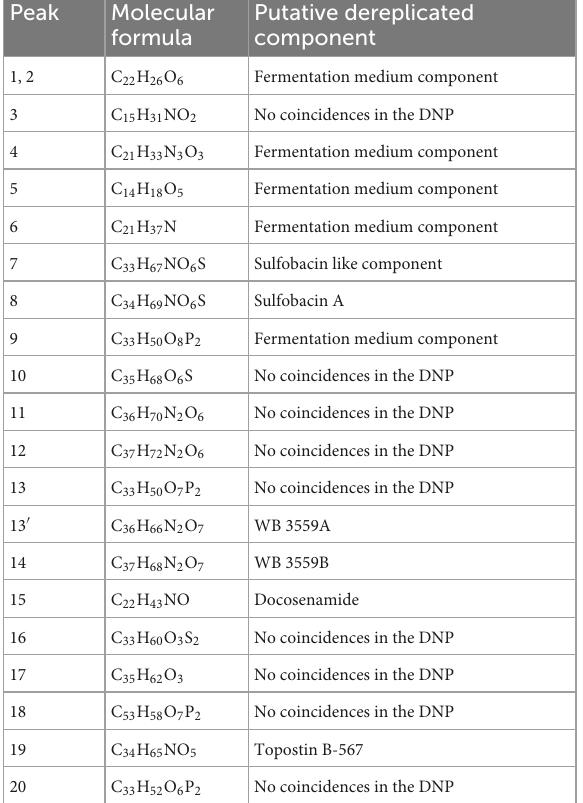
TABLE 3 Peaks with molecule formula and putative